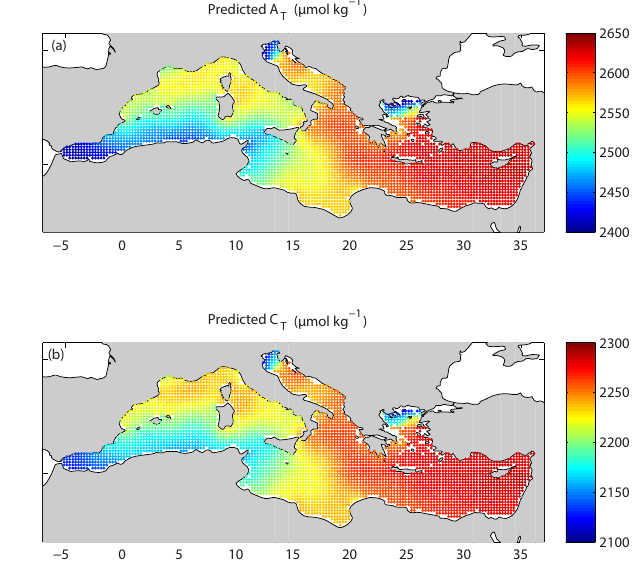
Figure 7. The 7-year averages of spatial variability for (a) sur- face A T predicted from Eq. (1) and (b) surface C T predicted from Eq. (2), applied to the 2005–2012 climatological fields of S and T from the WOA13.